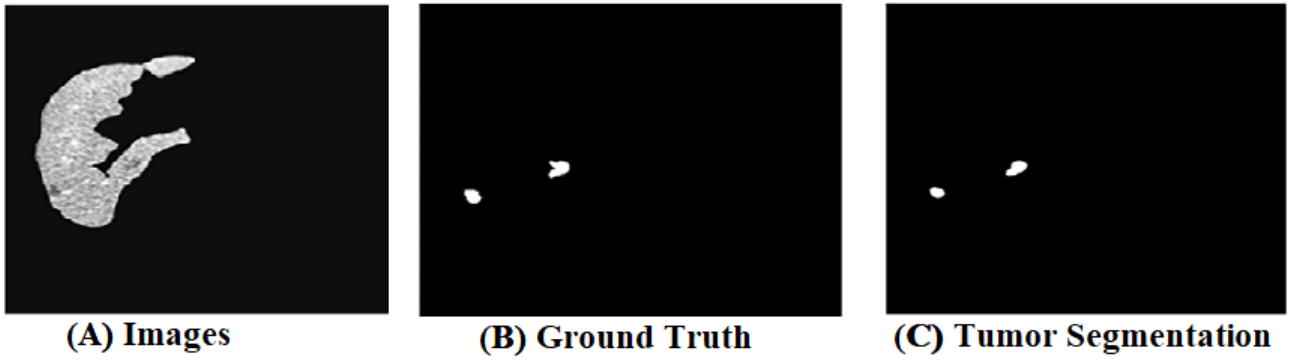
Figure 5. Tumour Segmentation. ( A ) Image; ( B ) Ground Truth; ( C ) Tumor Segmentation.